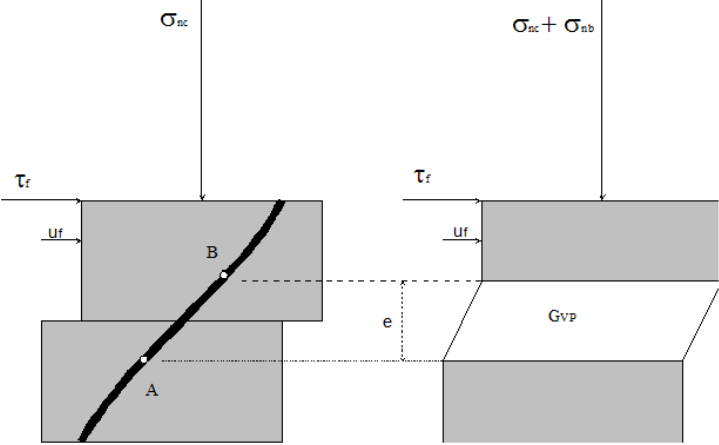
Figure 1. Virtual element for the rock with bolts.